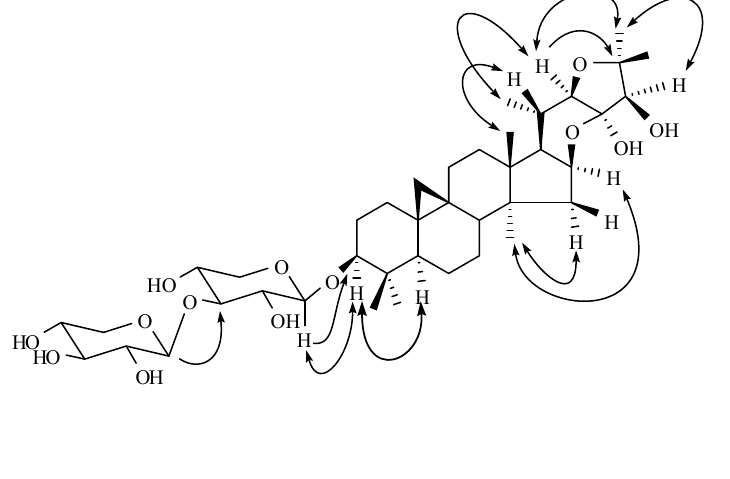
Figure 2 . The key HMBC ( → ) and ROESY ( ←→ ) correlations of compound 1